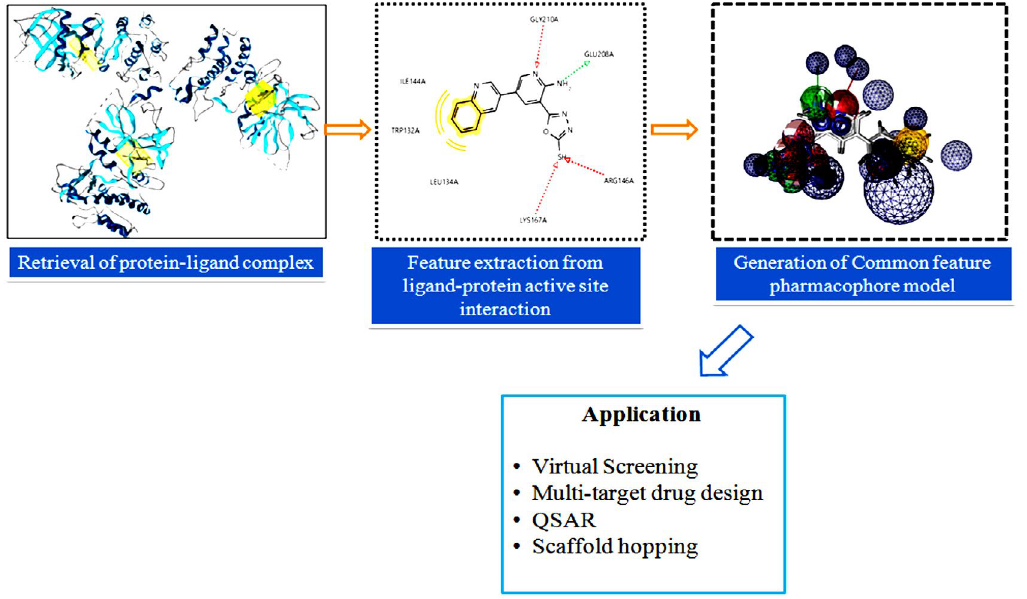
Fig. 9. Structure-based Pharmacophore modeling and its